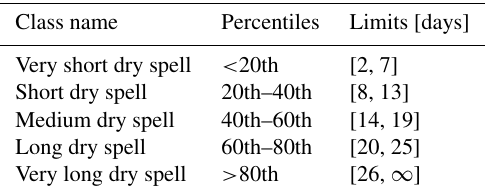
Table 4. Classification of dry spells based on their length along with the limits for each class derived from observed time